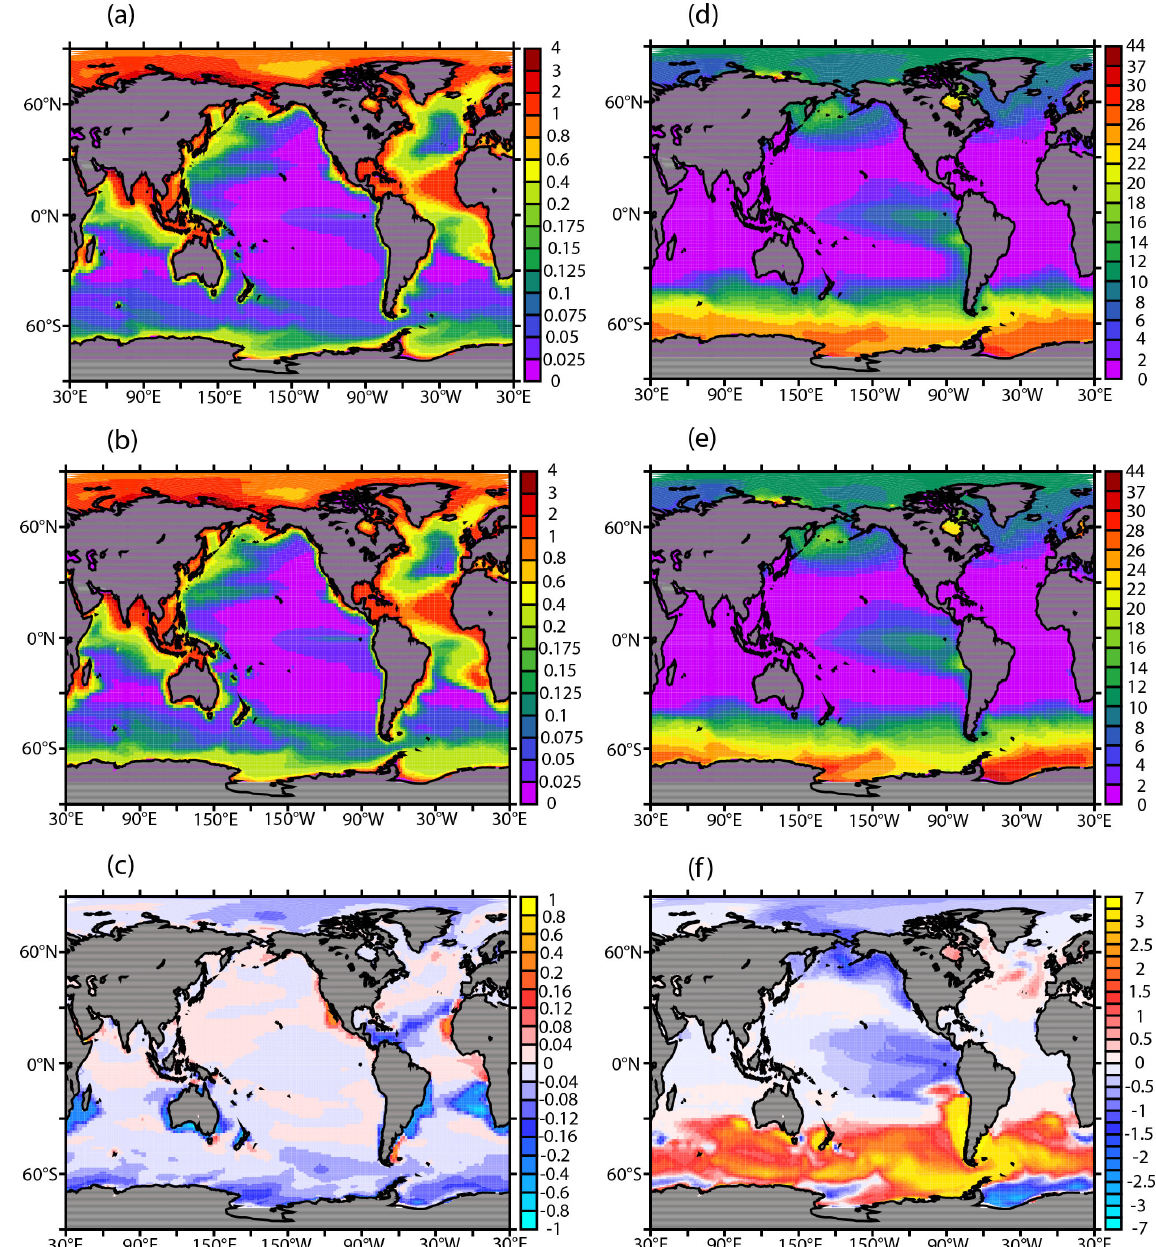
Figure 11. Surface concentrations are shown averaged over years 2000–2006 for (a) Fe in WSTIR, (b) Fe in CNTRL, and (c) the difference in Fe between WSTIR and CNTRL (units of nM). Surface concentrations are shown averaged over years 2000–2006 for (d) NO 3 in WSTIR, (e) NO 3 in CNTRL, and (f) the difference in NO 3 between WSTIR and CNTRL (units of